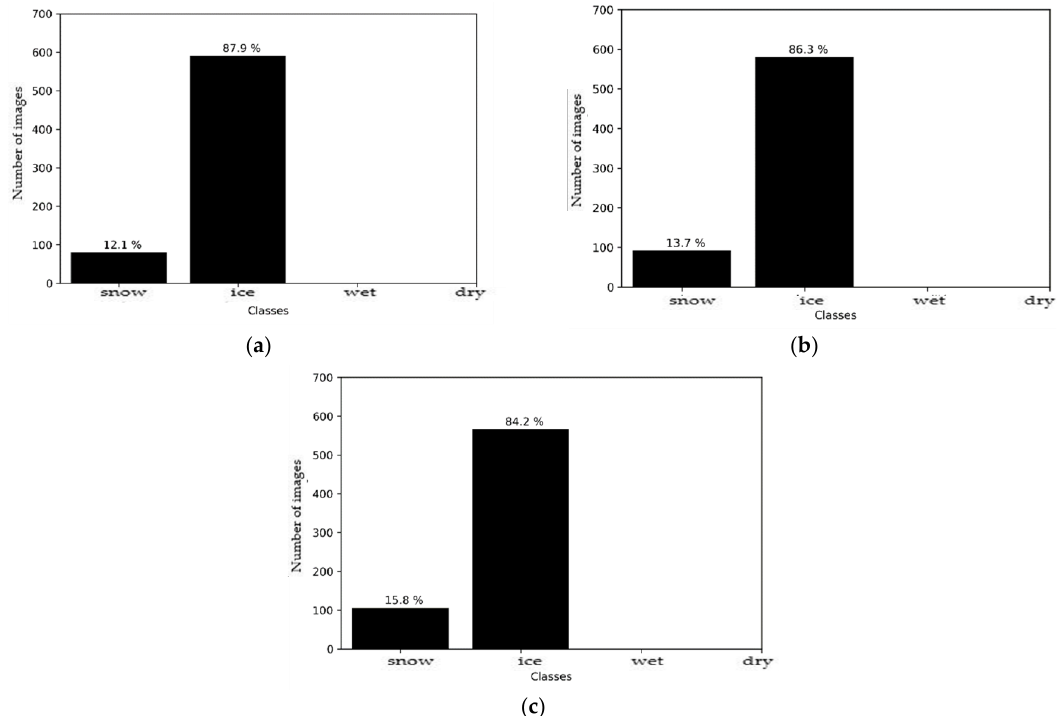
Figure 9. Environment #1. ( a ) Classification of sources with MobileNetV3_small (video) and M5 (audio) prior to fusion, together with conflict analysis; ( b ) histogram prior to image fusion.